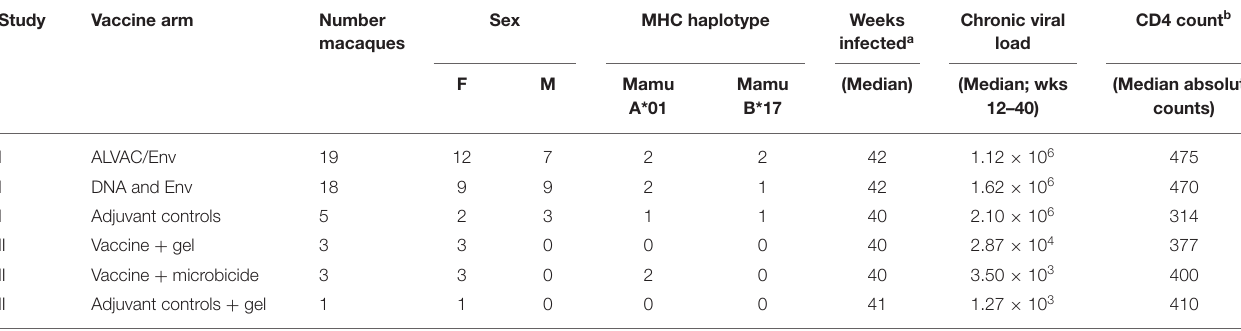
TABLE 1 | Summary of rhesus macaques used in this